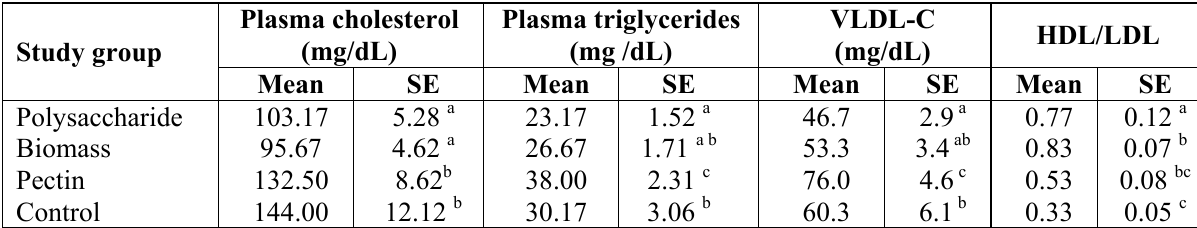
Table 3. Plasma lipid levels in rats fed with algal biomass or algal polysaccharide (AP)